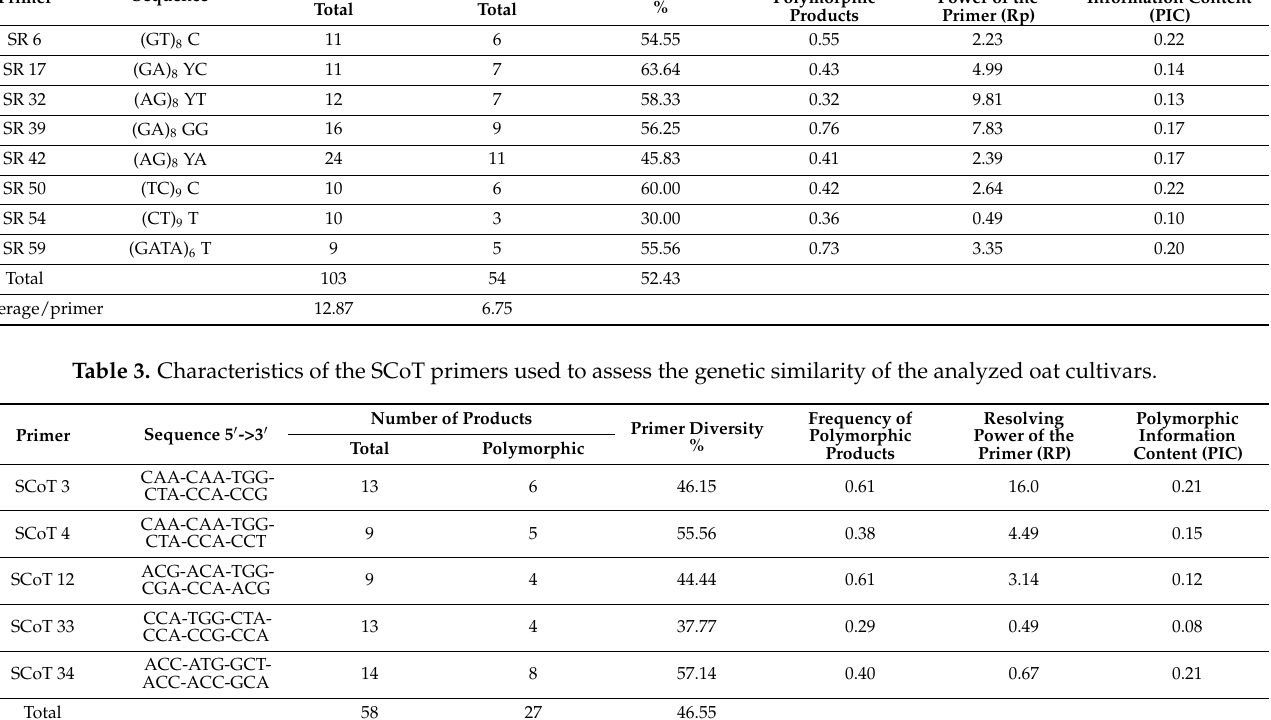
Table 2. Characteristics of the ISSR primers used to assess the genetic similarity of the analyzed oat cultivars. Primer Sequence